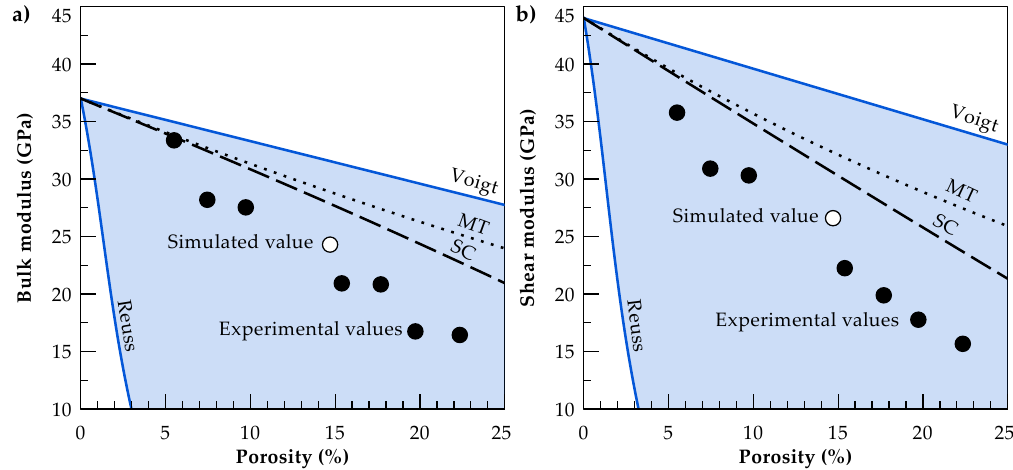
Figure 2. State-of-the-art analytical solutions as the Mori-Tanaka approach (MT, dotted line) and the self-consistent scheme (SC, dashed line) overestimate the experimentally determined ( a ) bulk and ( b ) shear moduli (black-filled circles) of the Fontainebleau sandstone [64], while numerical simulations (empty circle) based on a micro-CT scan [59] result in substantially better